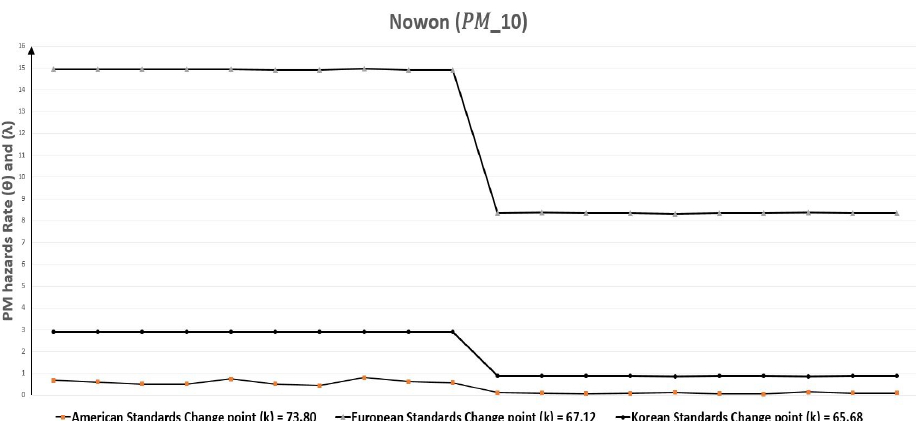
Figure 21. Nowon (Seoul, South Korea) monthly polluted days before and after the change point due to PM 10